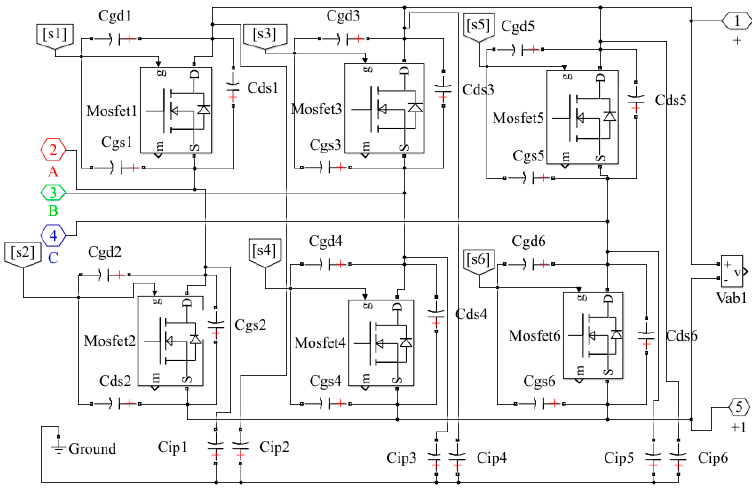
Figure 11. Three-phase converter bridge topology with parasitic parameters.